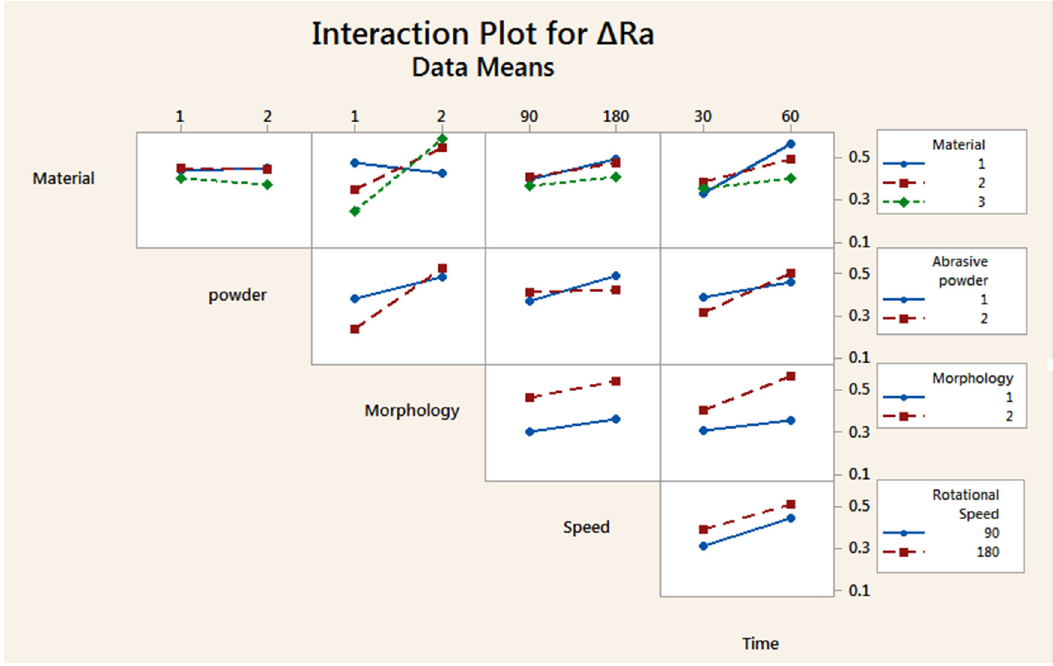
Fig. 11. Interaction plot for D Ra